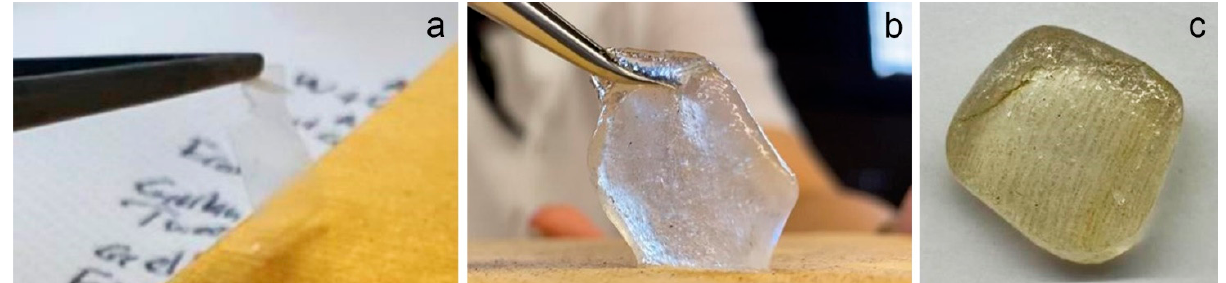
Figure 3. Images related to the application of ( a ) SA gel on the sweat-Western Mock-ups (WM) surface and ( b ) KG gel on the soiled-WM surface; ( c ) surface of KG gel after cleaning the soiled-East Asian Mock-ups (EAM).